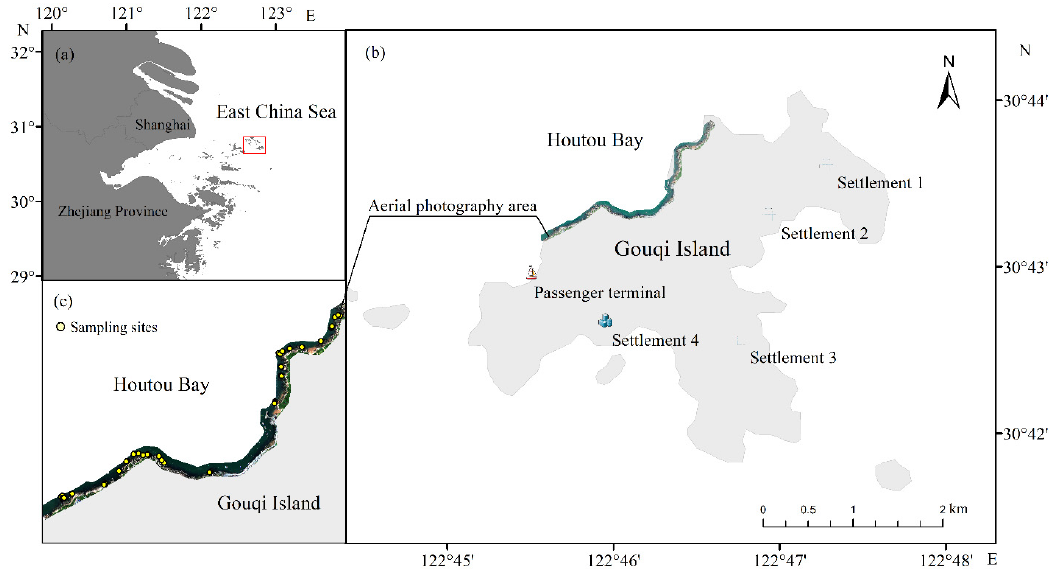
Figure 2. Study area. ( a ) is the approximate location of the study area, ( b ) is the location of aerial photography area in specific research area, ( c ) is the distribution of sampling